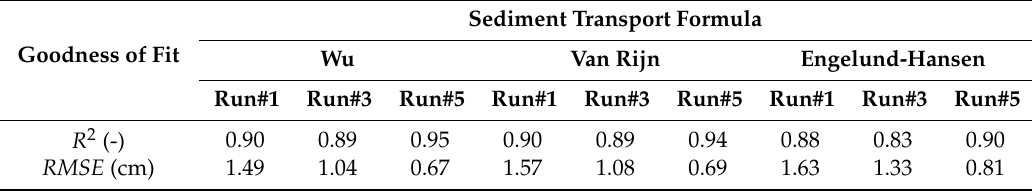
Table 5. Goodness of fit for the calibrated models with different sediment transport formulae. Goodness of Fit